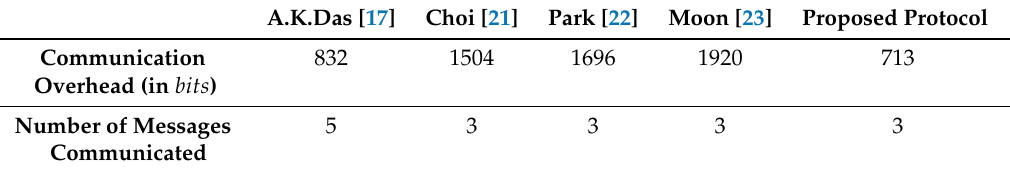
Table 29. Comparison of protocols based on communication